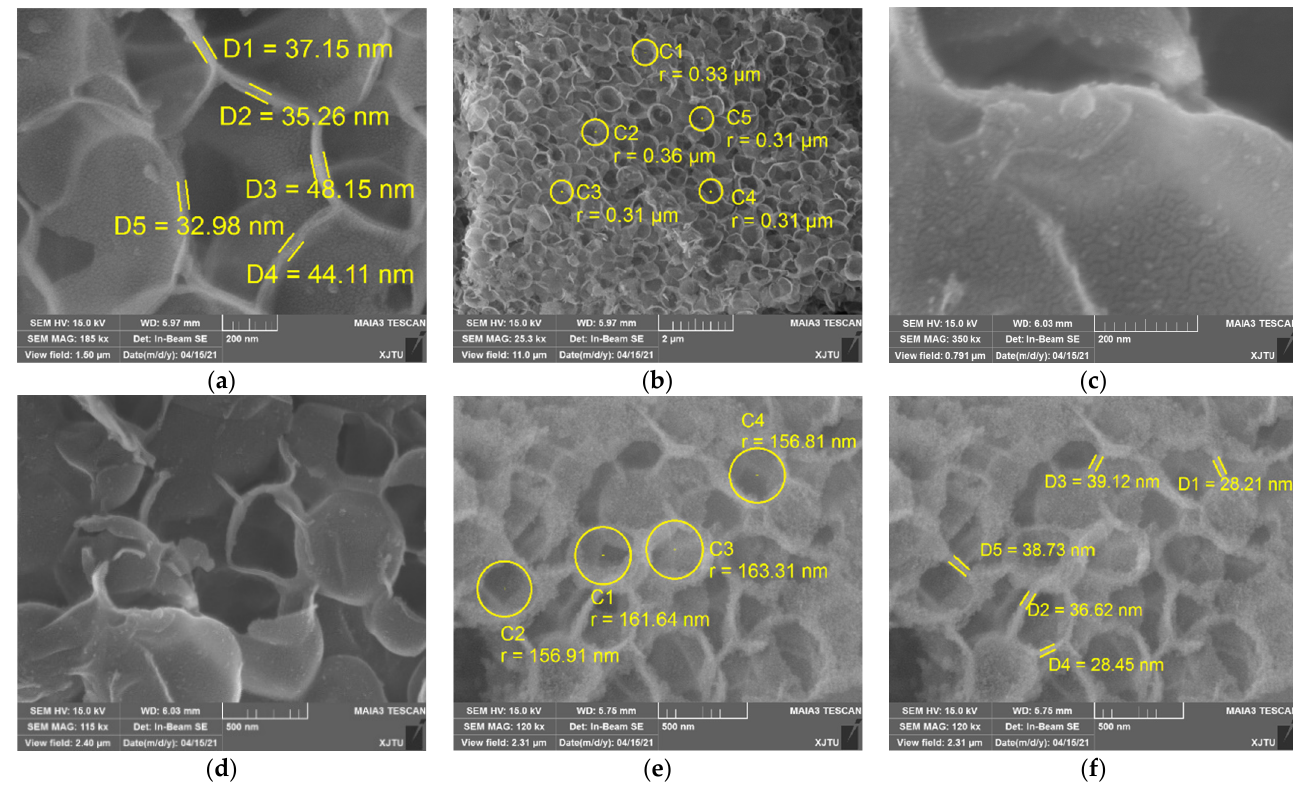
Figure 4. SEM images w -SiO 2 ( a – d ) and n -SiO 2 ( e , f )